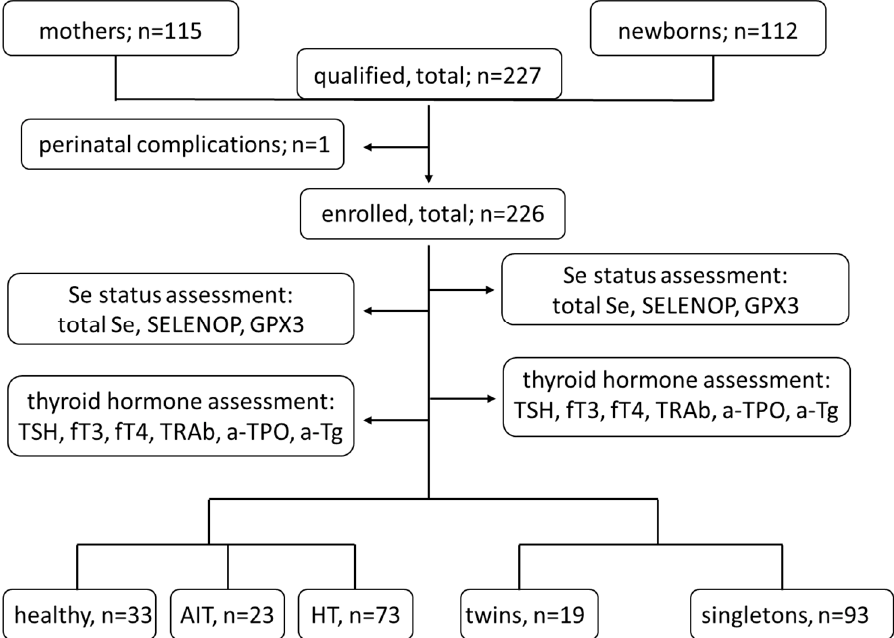
Figure 1. Overview of the mothers and children enrolled in the analysis. The group of mothers was finally divided into three groups of healthy women and mothers with different thyroid diseases, and the group of newborns consisted of a few twins and a majority of singletons. HT group comprised 15 patients with concomitant AIT, including euthyroid subjects on levothyroxine; one child from twin pregnancy had insufficient cord blood volume to perform the analysis. In terms of the related mothers and newborns calculations, 101 pairs were included in the analyses. AIT—autoimmune thyroiditis; HT—hypothyroidism; TSH—thyrotropin; fT4—free tetraiodothyronine; fT3—free triiodothyronine; TRAb—autoantibodies to TSH-receptor; a-TPO—autoantibodies to thyreoperoxidase; a-Tg—autoantibodies to thyroglobulin; Se—selenium; SELENOP—selenoprotein P; GPX3—plasma glutathione peroxidase.